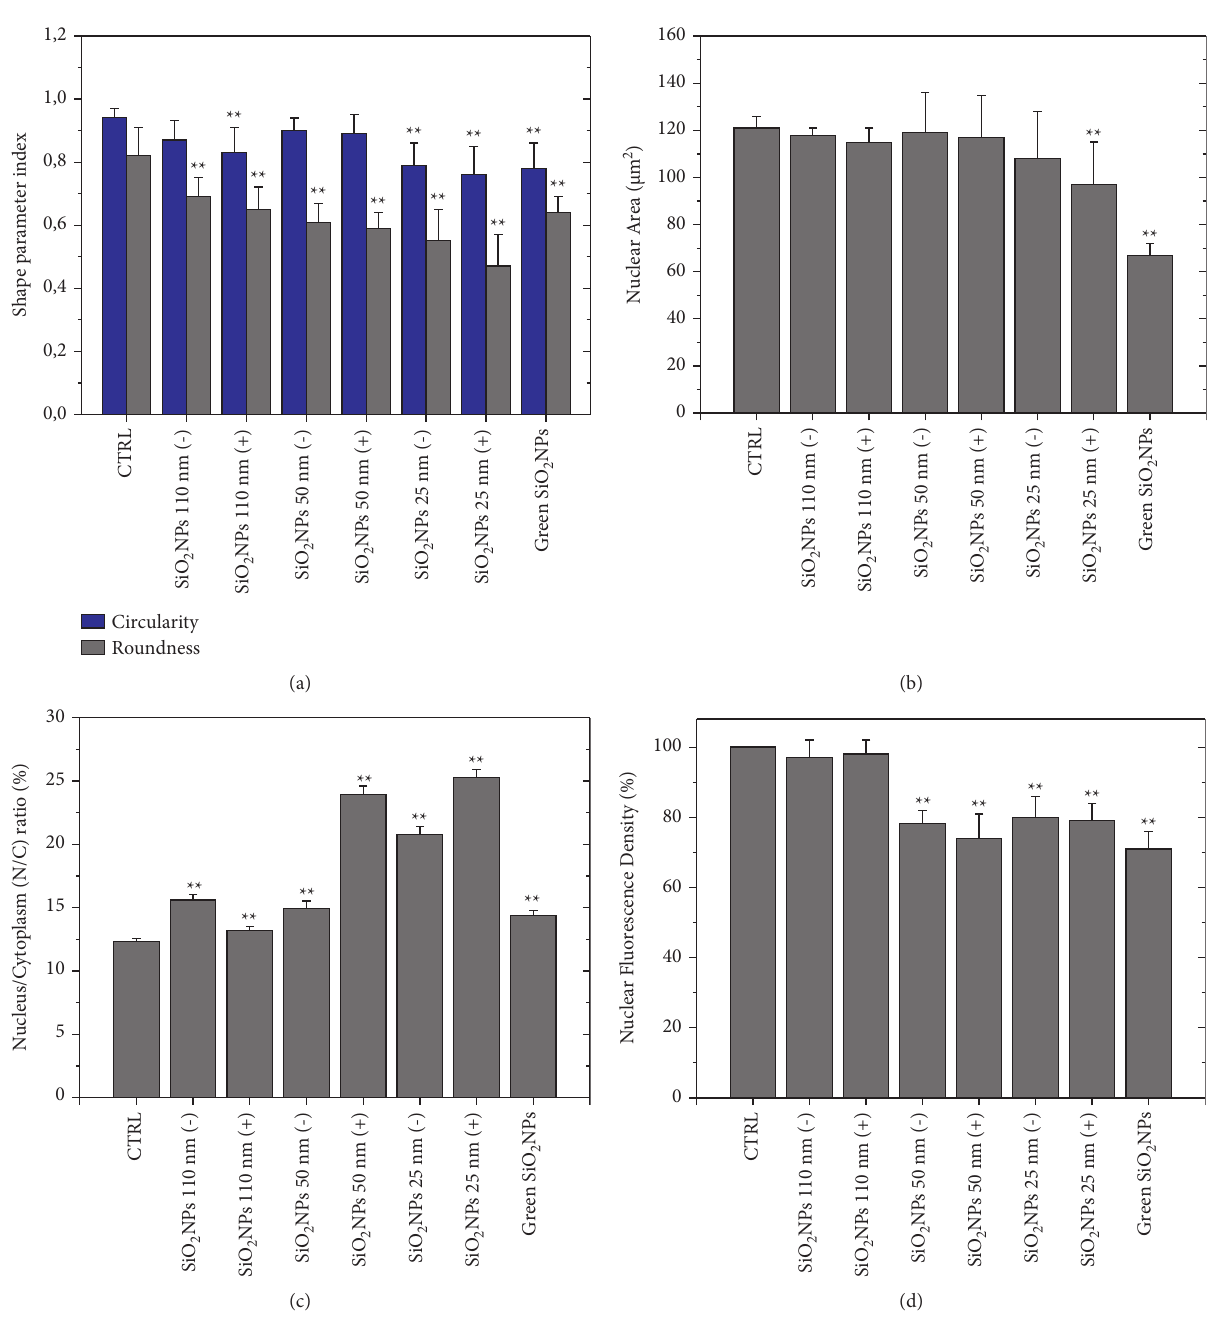
Figure 10: Histograms reported the mean values and their respective standard deviation of shape parameter index (circularity and roundness) (a), nuclear area (b), nucleus/cytoplasm ratio (N/C) (c), and nuclear fluorescence density (d). The statistical significance of results compared to the control cells was evaluated by Student’s t -test and reported in histograms for ∗∗ p < 0 .